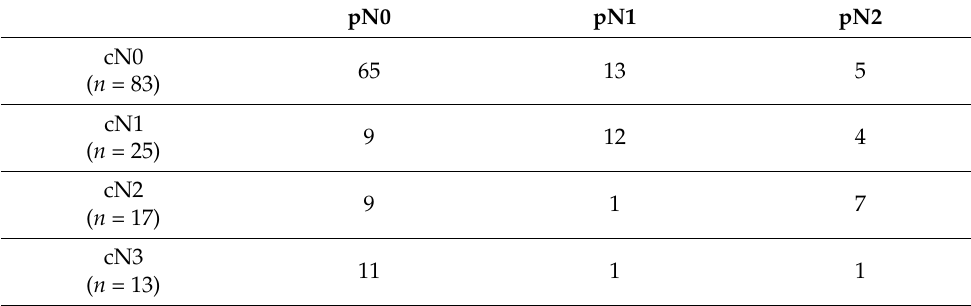
Table 2. Correlation between clinical PET N factor and pathological N factor.